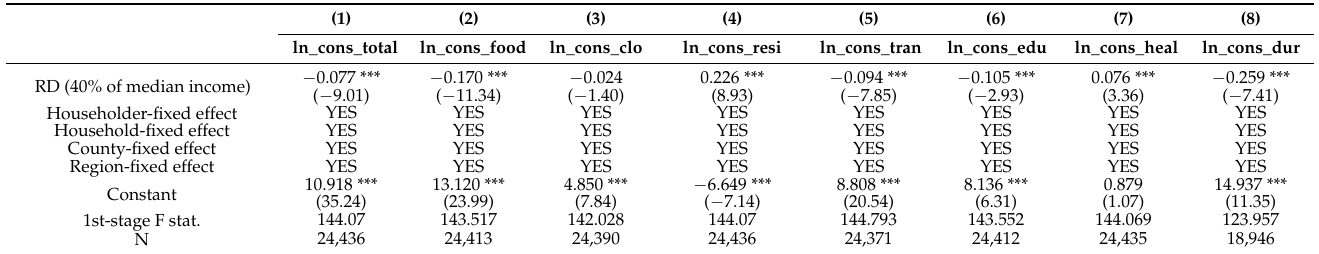
Table 3. Results of baseline regressions: IV